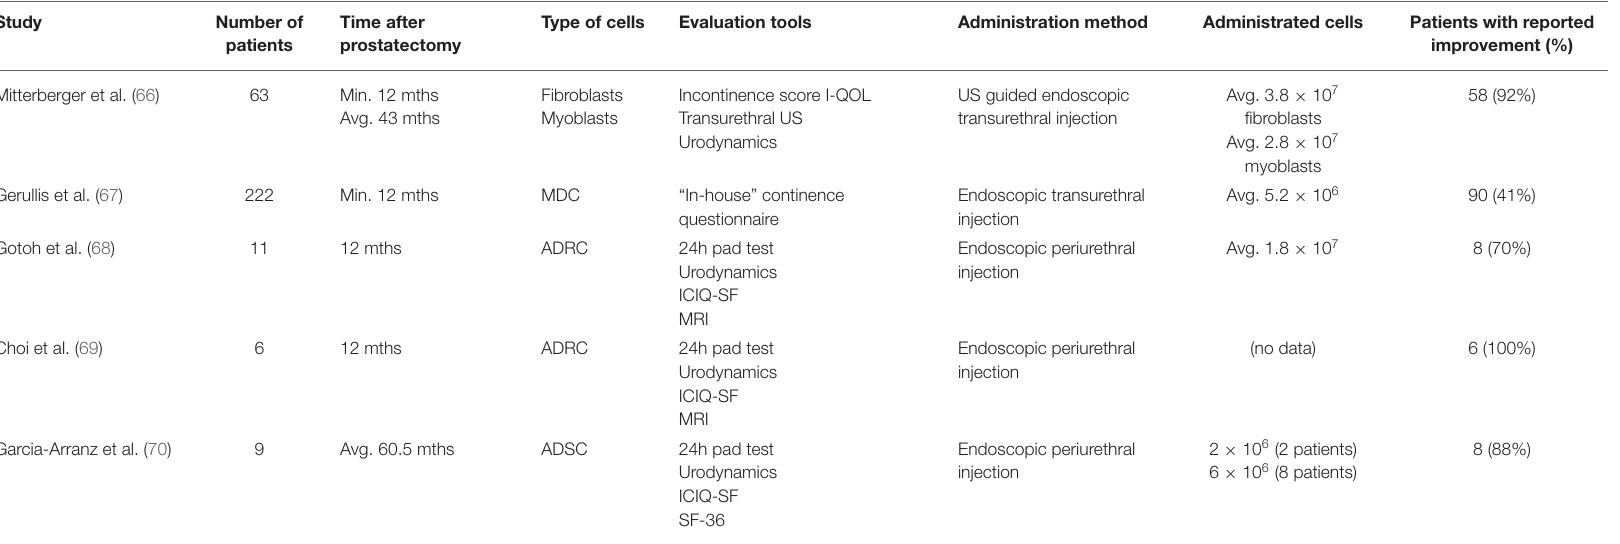
TABLE 1 | Cell therapy clinical trials for stress urinary incontinence after